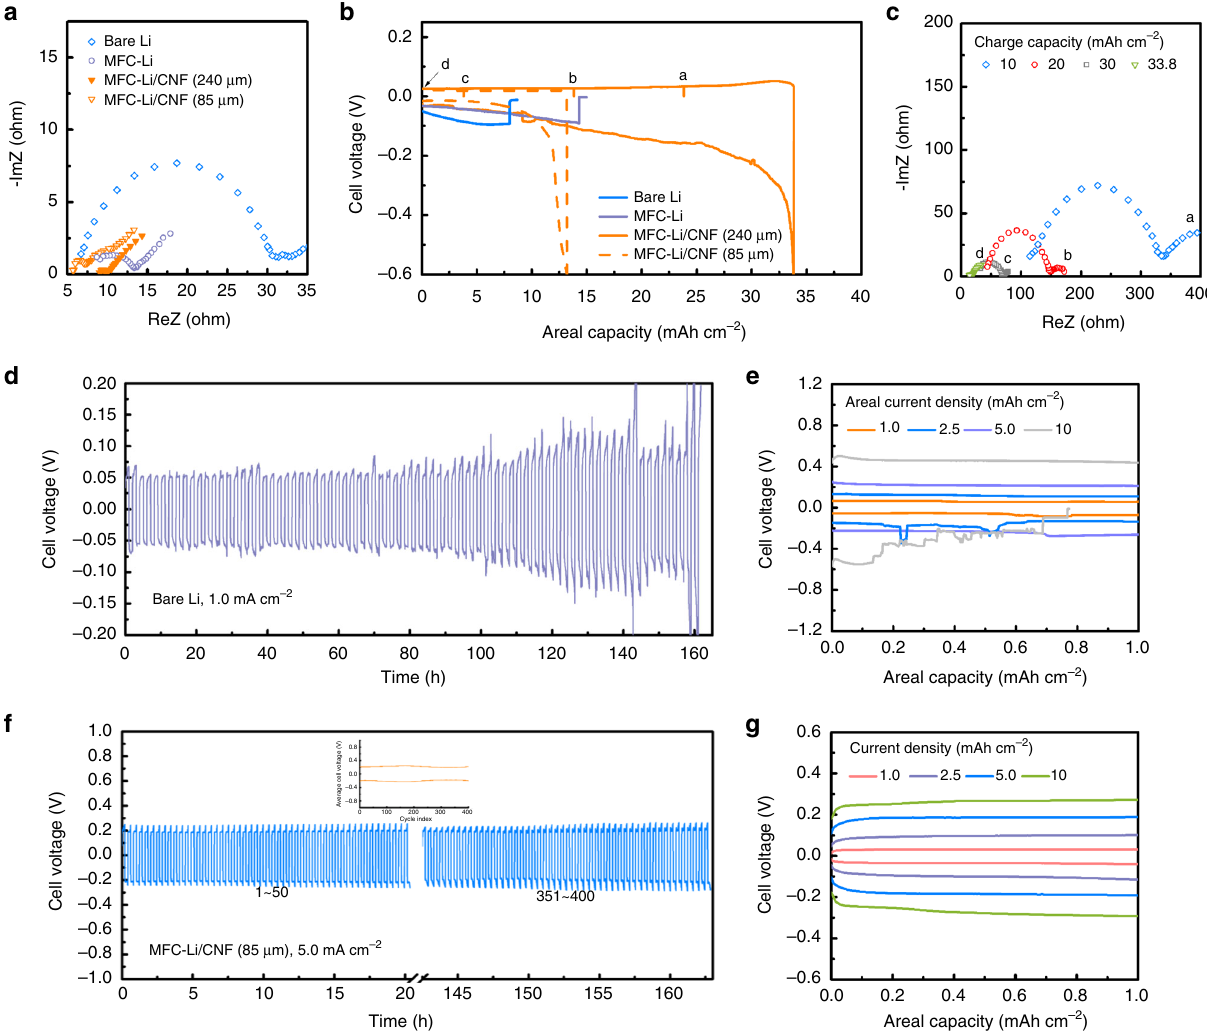
Fig. 5 Symmetric cell tests with MFC-Li/CNF electrodes. a EIS measurement results of symmetric cells assembled with different Li electrodes. b Long-term discharging pro fi les before short circuit (0.5 mA cm − 2 ) for the symmetric cell with different Li electrodes; c EIS measurement results of the MFC-Li/CNF electrode with different charge capacities. d Representative cycling voltage pro fi les at 1.0 mAh cm − 2 at 1.0 mA cm − 2 for the symmetric cell assembled with the bare Li metal (79 cycles); e voltage pro fi les at different current densities. f Representative cycling voltage pro fi les at 1.0 mAh cm − 2 at 5.0 mA cm − 2 for the symmetric cell assembled with the MFC-Li/CNF electrode, the inset shows the average cell voltage versus the cycle index; g voltage pro fi les at different current